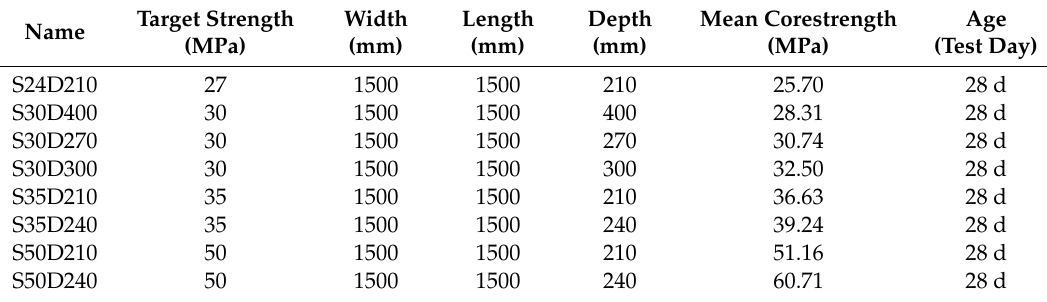
Table 1. Dimensions, target strengths, and actual strengths of specimens.